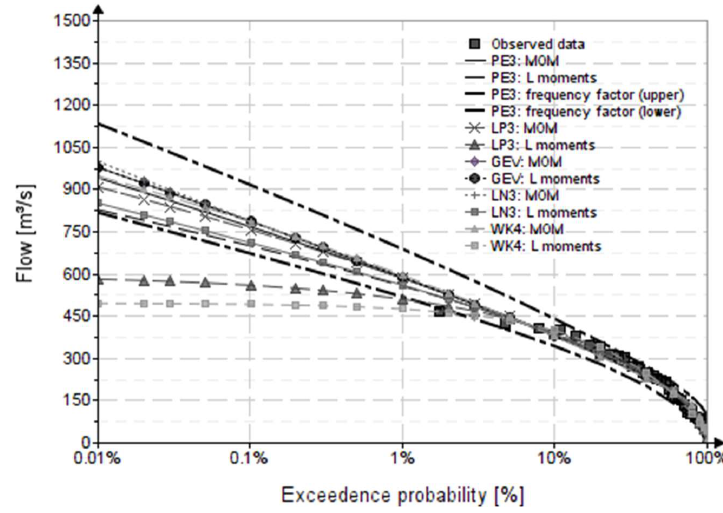
Figure 14. Comparing the frequency distributions for the Ialomita river.